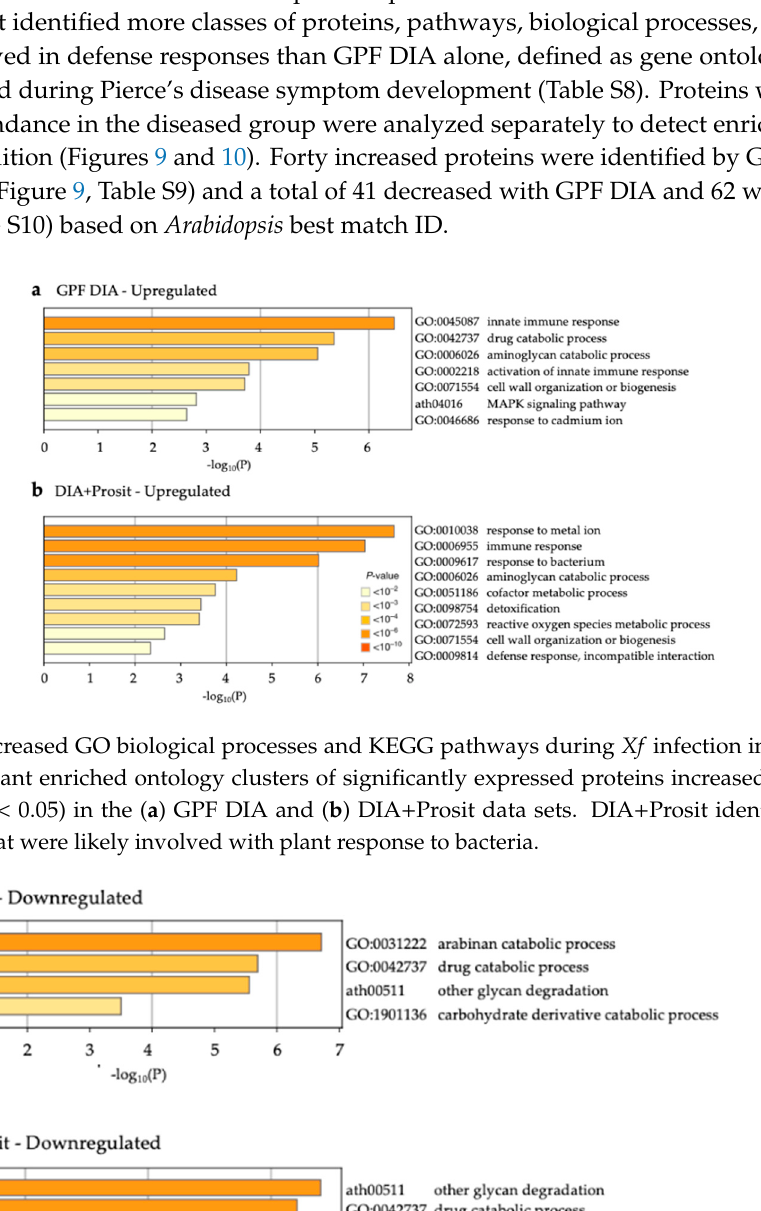
DA. The plot shows the variable importance in projection (VIP) scores, and the colored boxes indicate the relative intensity of the corresponding protein in diseased (D) and healthy (H) plants detected by ( a ) GPF DIA and ( b ) DIA+Prosit. Red represents detection of high and blue, of low exclusive intensity. Proteins marked with an asterisk (*) are among the top 25 regardless of method. The common 139 proteins detected using both methods were used.